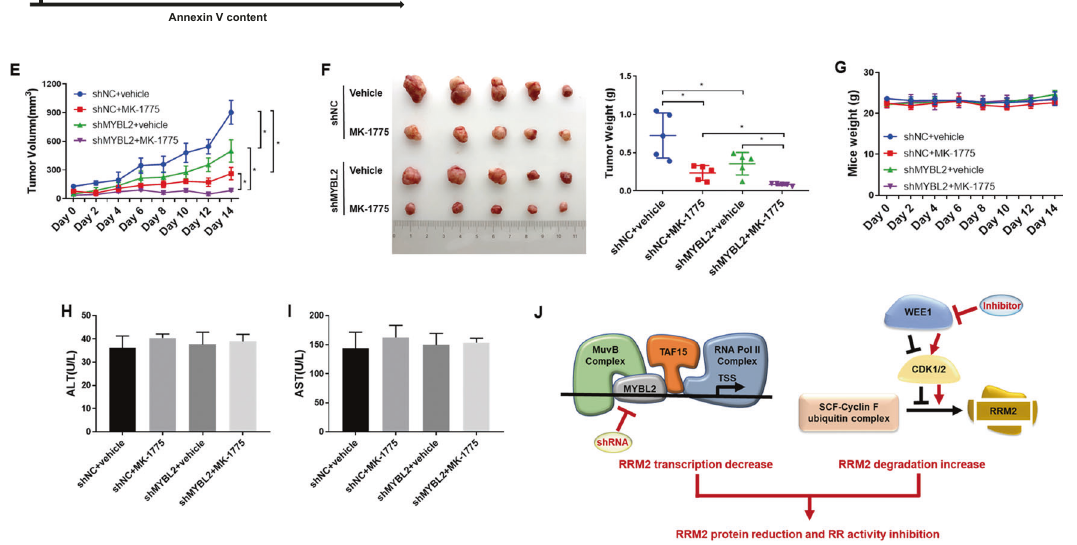
treated with 60 uM lovastatin for 36 h. For the knockdown of RBBP4 and LIN9, we obtained the sequences of siRNAs according to literatures [42, 43], while others were listed in Table S3. For lentiviral transduction, the short hairpin RNAs (shRNA) targeting MYBL2 and nontarget control (shNC) were purchased from Hanbio (Shanghai, China) and used to establish stable-transfected HCT116 cell